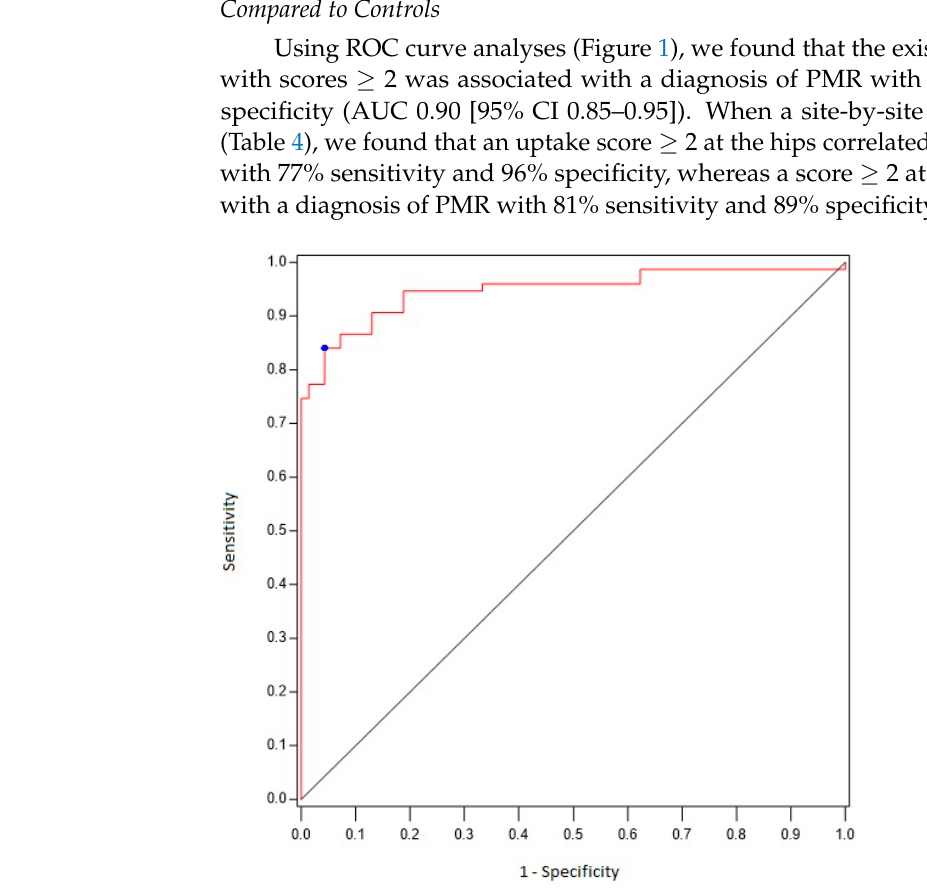
Figure 1. ROC curve analyzing the performance of FDG-PET/CT (number of sites) for the diagnosis of PMR. Table 4. Optimal cut-off values for FDG uptake